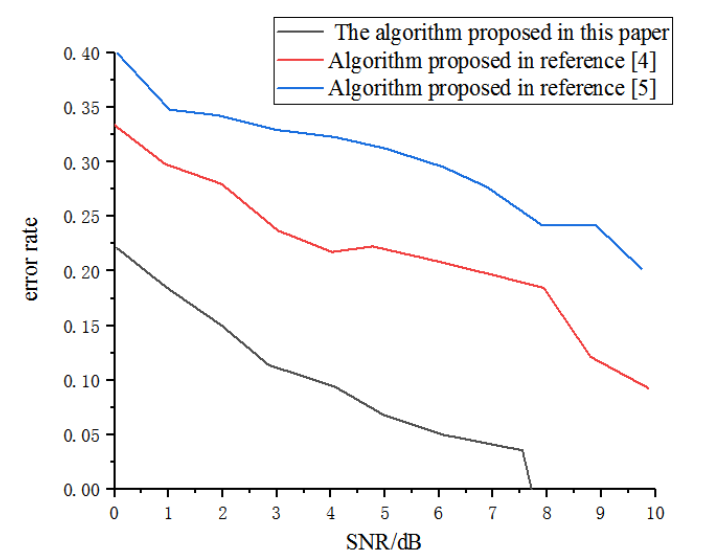
Fig. 2 Performance comparison of data